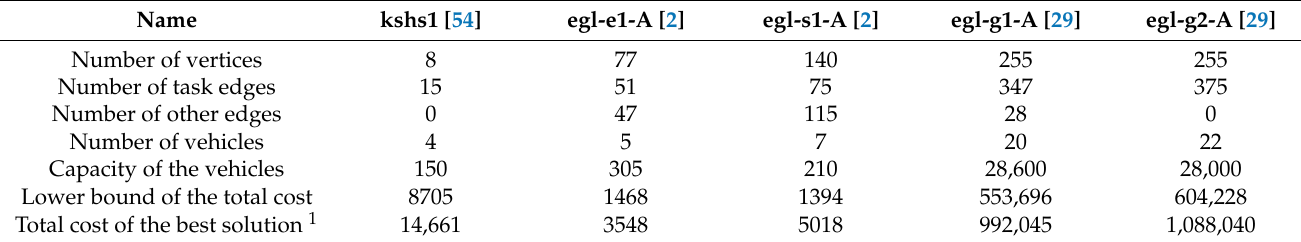
Table 2. Attributes of the used CARP